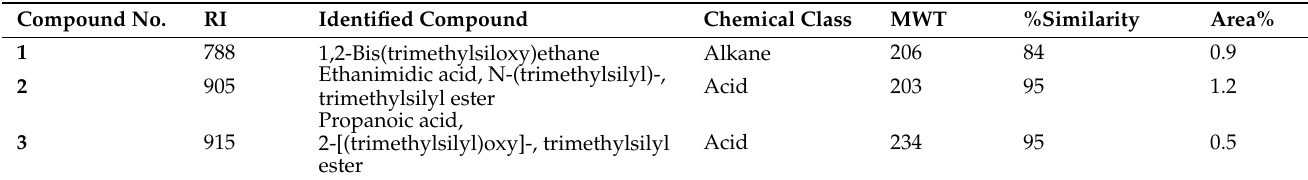
Table 3. Composition of the chloroform extract from the O. europaea leaves according to the GC-MS analysis. Compound